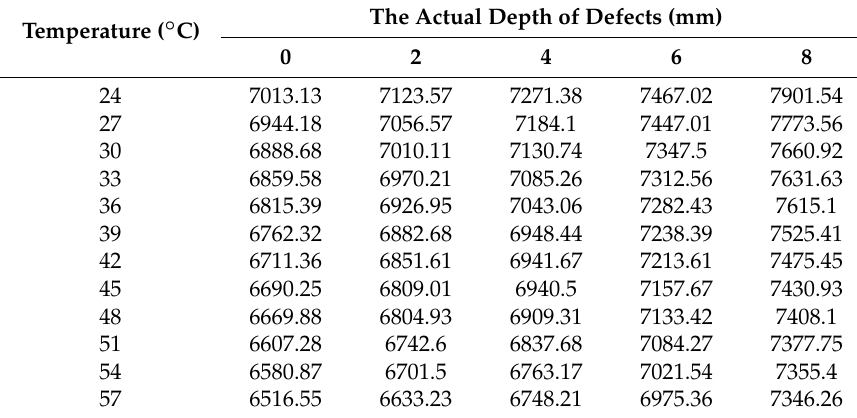
Table 1. The peak-to-peak values of the output signals under different